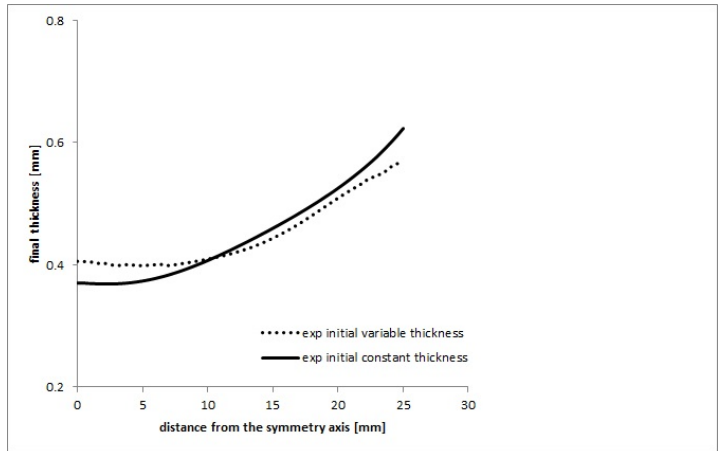
Figure 5. Experimental results for blank with variable and constant thickness.